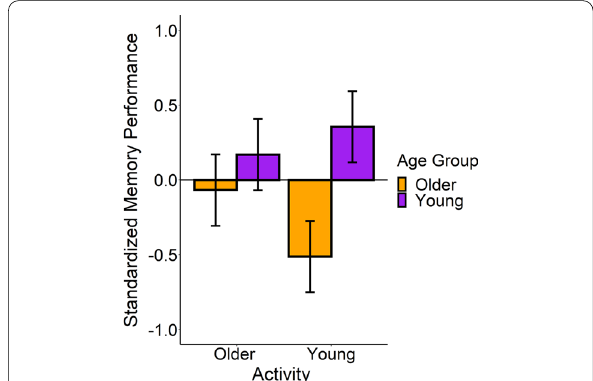
Fig. 5 Event memory performance as a function of activity and age group. Young adults had significantly better memory for the young adult activities, but older and young adults did not differ in their memory performance for content in the older adult activities. Error bars represent 1 standard error around the estimated